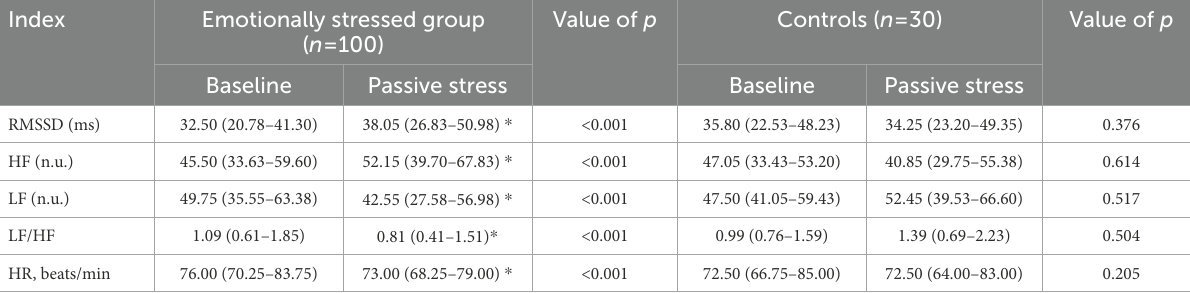
TABLE 4 HRV indices before and after the passive stressor in the stress and control